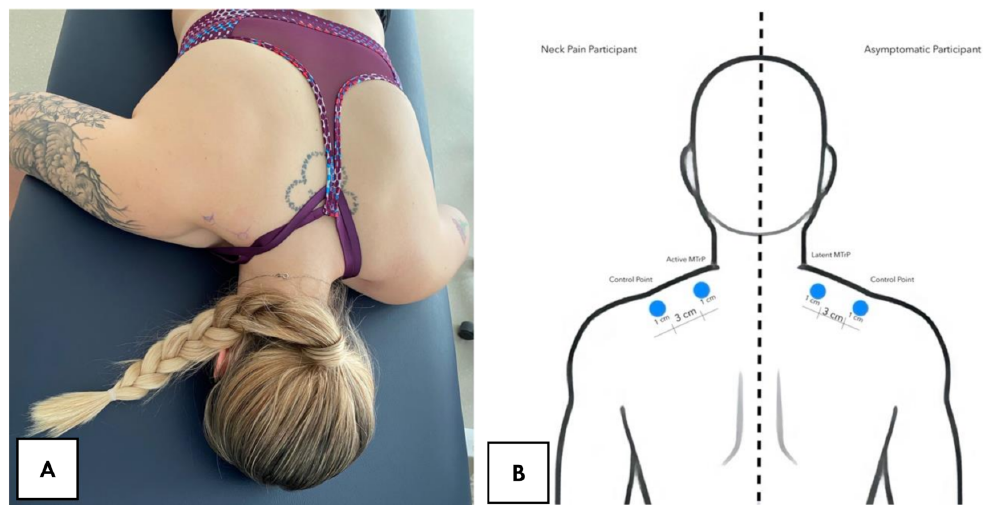
Figure 1. ( A ) Participants positioning; ( B ) Measurement points location.